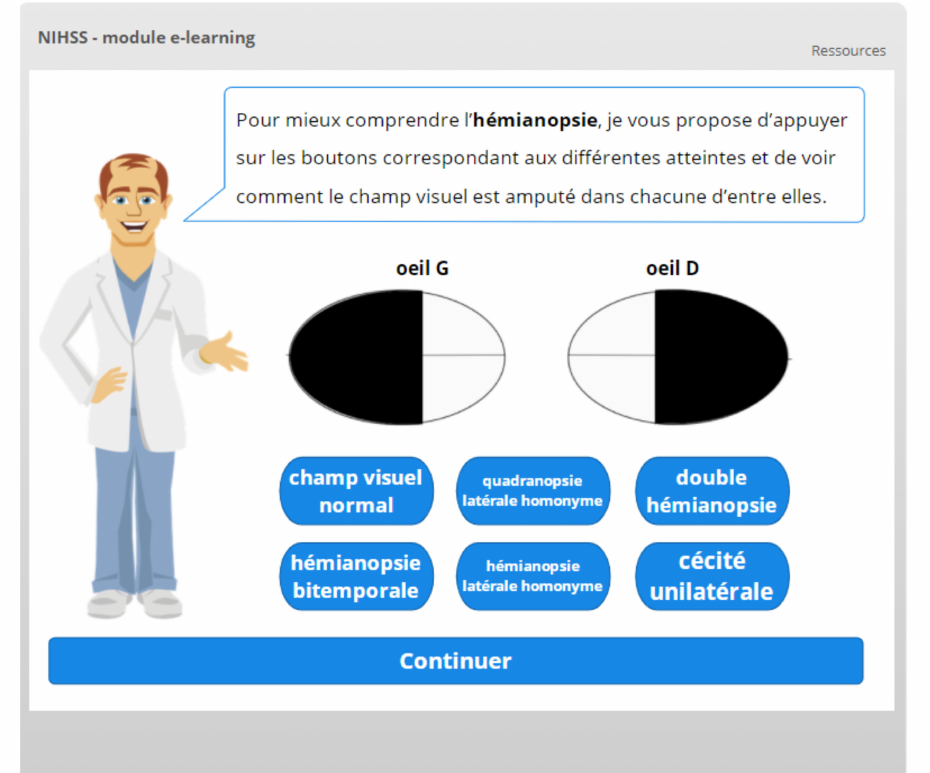
Figure 5. Interactive slide used to remind or teach visual fields.